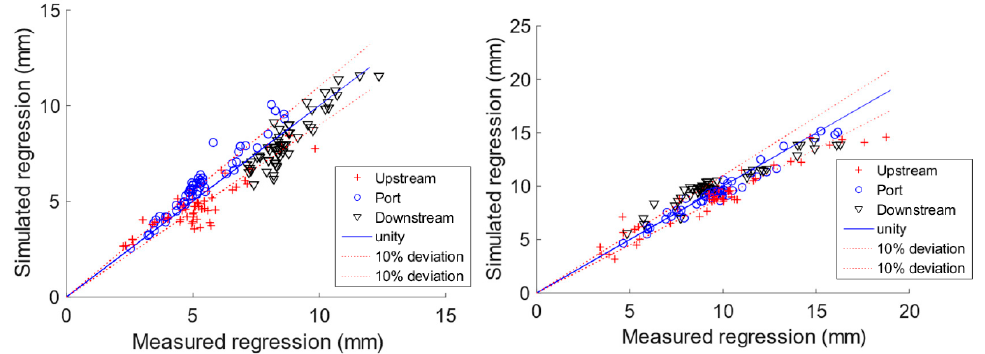
Figure 6. Model baseline performance for D100 ( left ) and D230 ( right ).